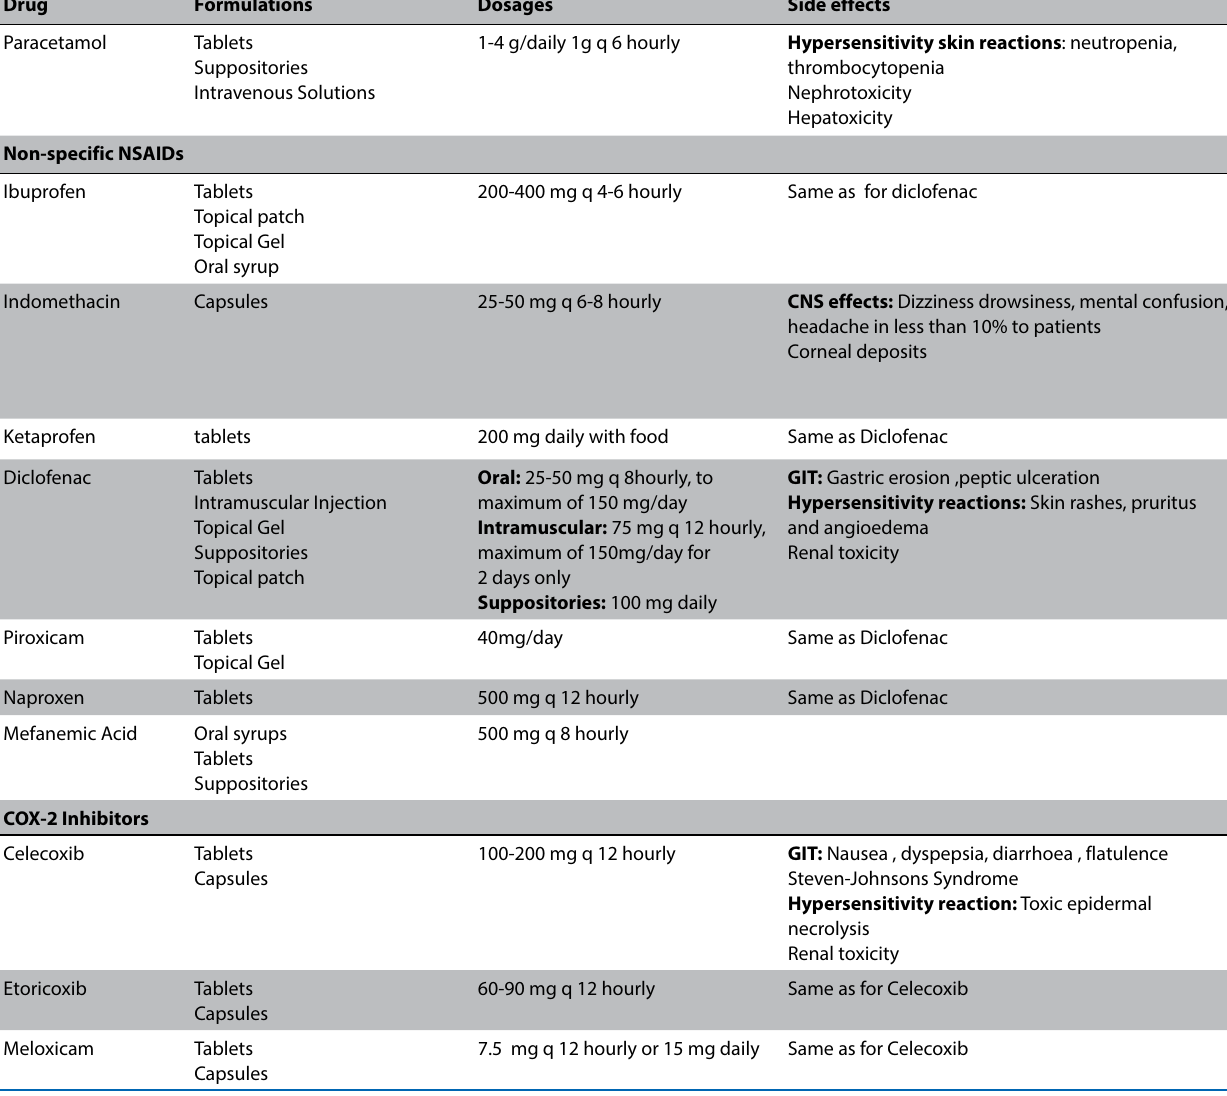
Table 1: Formulations, dosages and side-effects of various pain medications